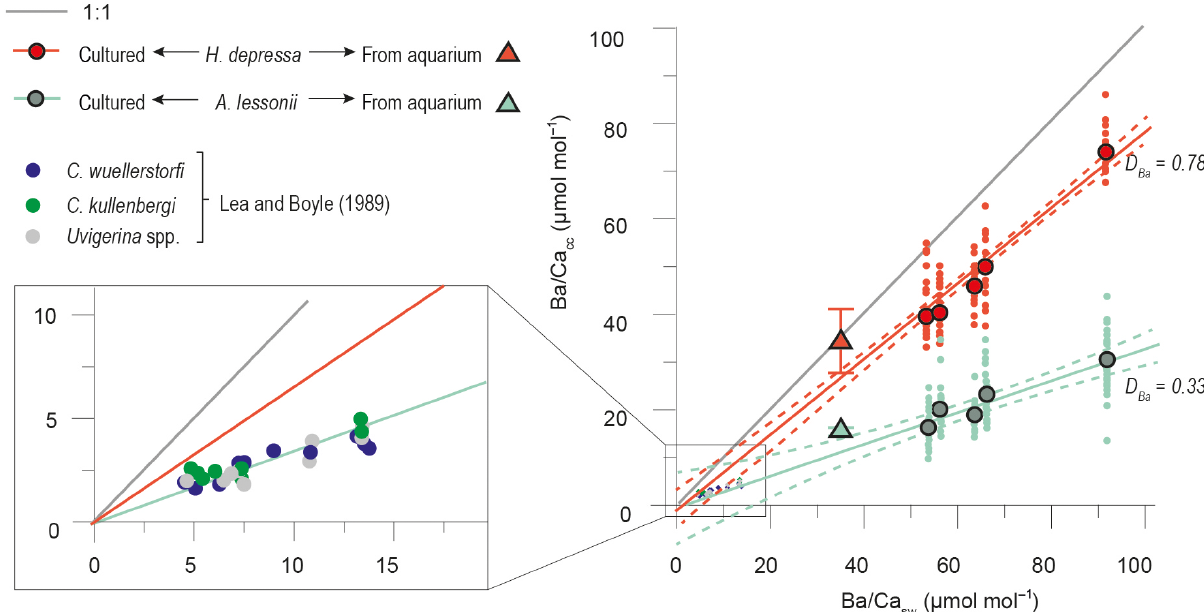
Figure 2. Foraminiferal Ba / Ca as a function of seawater Ba / Ca. Light circles indicate individual laser ablation measurements. Larger, darker shaded circles represent the average Ba / Ca cc for one treatment. Relative standard deviation varies between 16 and 20% for Ba / Ca cc in A. lessonii and between 5 and 15% for H. depressa . Average Ba / Ca ratios for the two species collected from the aquarium are indicated by triangles ( ± 1SD) and were not taken into account when calculating the regression. Calculated regressions are accompanied by their 95% confidence intervals (dashed lines) over the Ba / Ca sw range from 50 to 90µmolmol − 1 . Data from Lea and Boyle (1989) are plotted additionally for comparison.